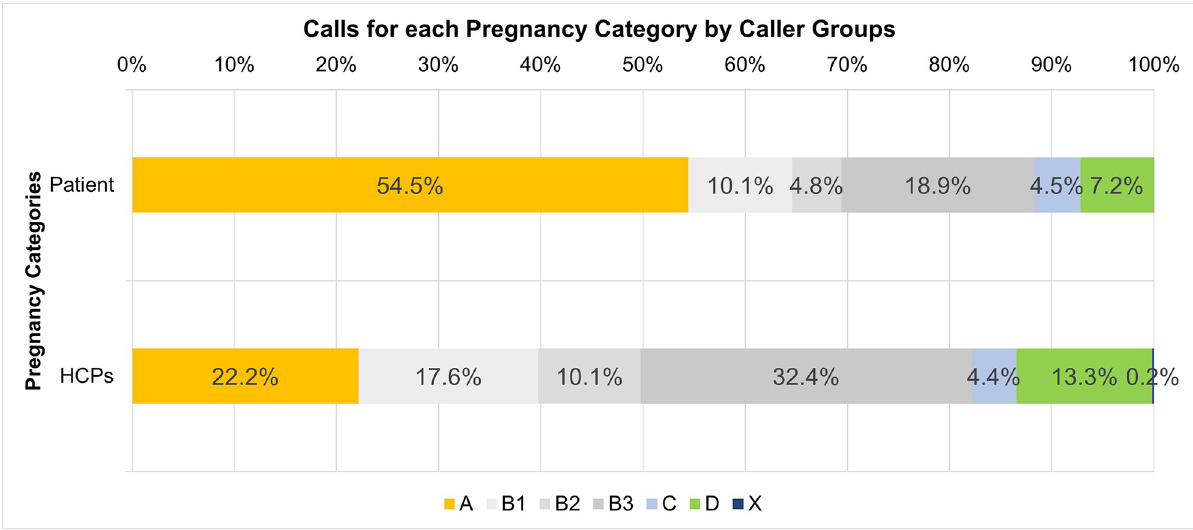
Fig 1. Pregnancy categories of all enquiries during pregnancy by caller type (patient or HCP).